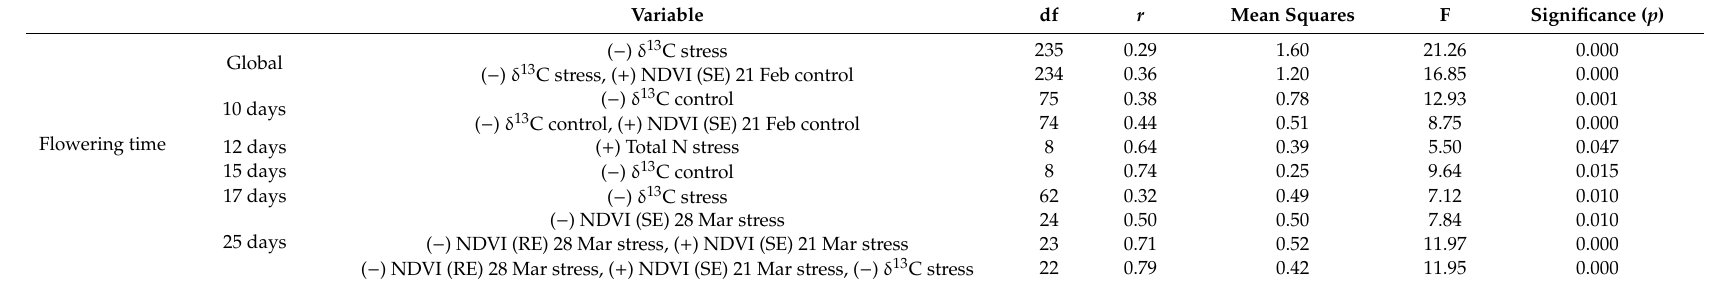
Table 3. Stepwise analysis for the entire 248 panel of durum wheat elite advanced lines and cultivars from around the world with biomass as a dependent variable, and the following independent variables: Carbon stable isotope composition ( δ 13 C) and total nitrogen (Total N) concentration of the flag leaf dry matter sampled before stress conditions were imposed in the field (control) and two weeks after the last irrigation (stress), flowering time, and the Normalized Di ff erence Vegetation Index (NDVI) using Sequoia (SE) and RedEdge (RE) sensors measured on di ff erent days after planting. The “global” stepwise analysis represents values obtained by considering accessions from all flowering times together. The 10, 12, 15, 17, and 25 days of flowering represent the stepwise analyses obtained with accessions within each flowering time